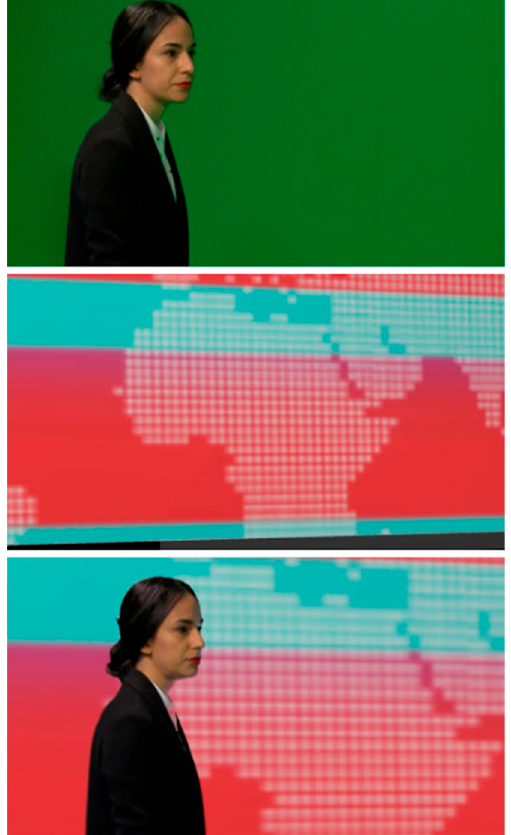
Figure 1. Camera captured image ( top ), computer generated image ( middle ) and final composition ( bottom